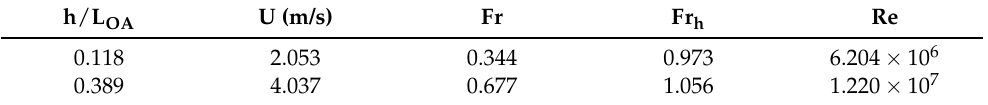
Table 2. Calm water resistance computations of Delft 372 catamaran (BSHC) model: test matrix.